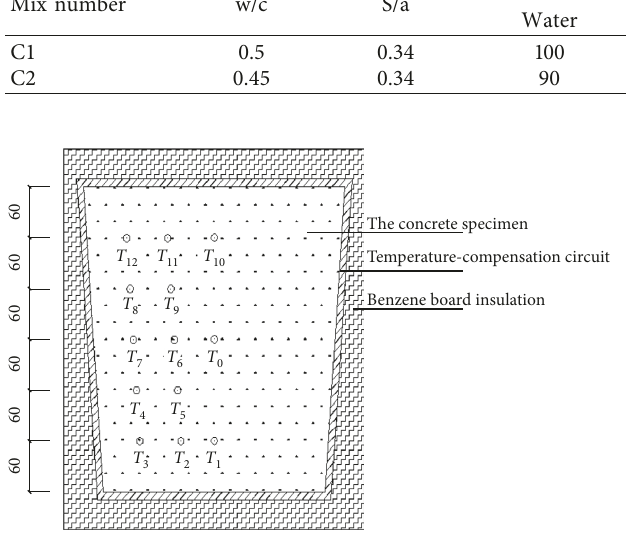
Figure 1: The location of sensors of adiabatic test (unit: